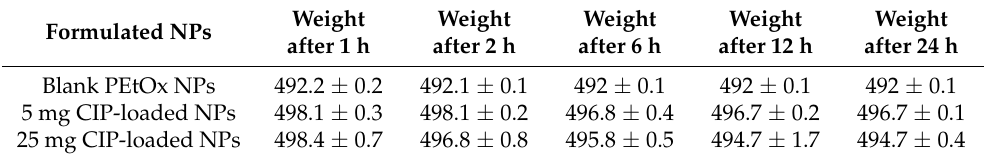
Table 1. Weights of the compounds in the loss-on-drying process (data mean with ± S.D., n = 3). Weight Formulated NPs after 1